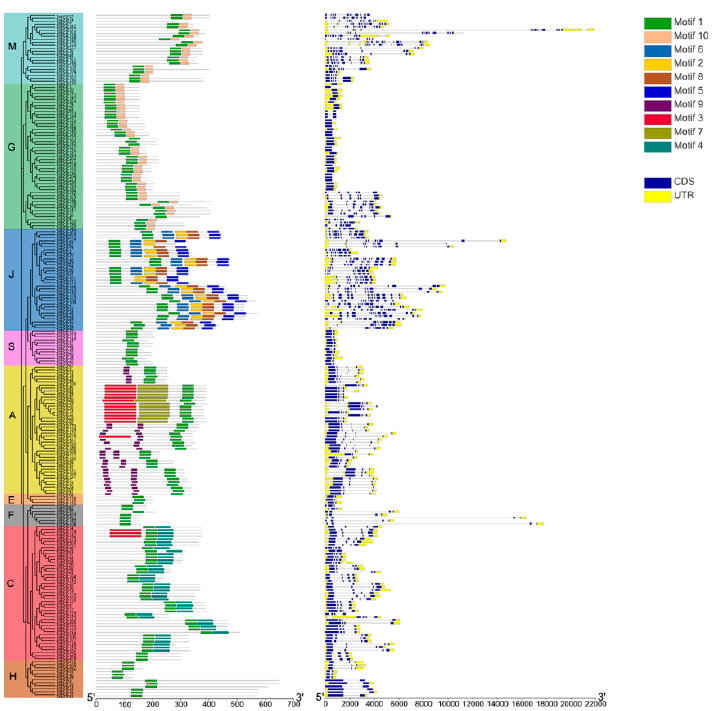
Figure 2. Distribution of introns-Exons and Conserved motifs of the TabZIP gene family in wheat. ( Left ) phylogenetic relationship and location of Conserved motifs on each gene and ( right ) distribution of exons/introns of the gene family in wheat.